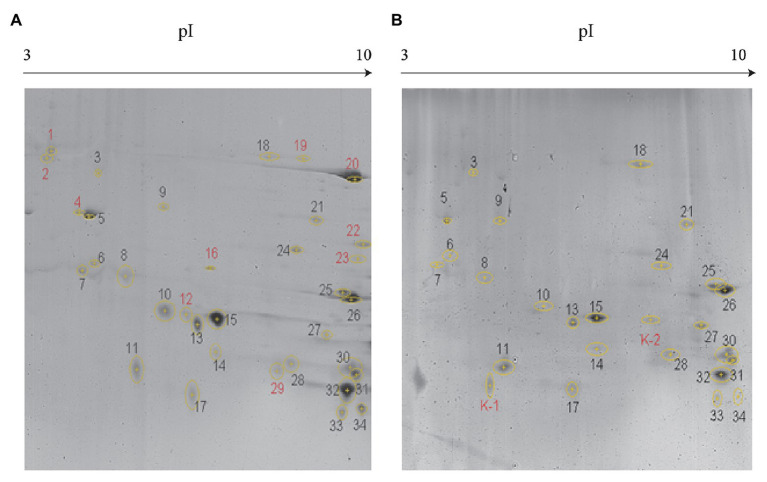
Identification of secreted protein by two-dimensional gel electrophoresis (2-DE). Discrimination of secreted proteins between JHY20 (A) and JHY20△ICE (B). Twelve discrepancy protein spots were detected in the supernatant of strain, indicated by numbers in red.